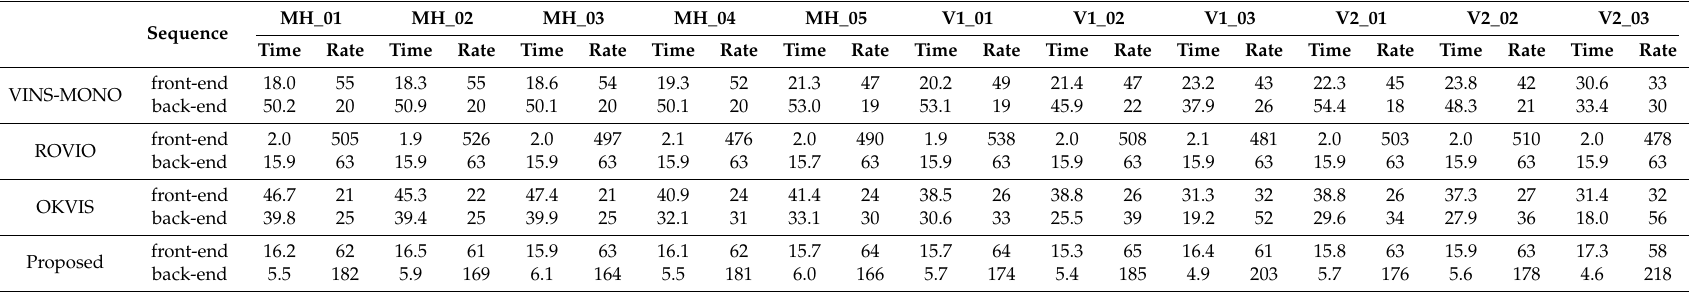
Table 5. Average processing time (ms) and rate (Hz) of visual front-end and EKF/optimization back-end of our implementation and the state-of-the-art using the EuRoC